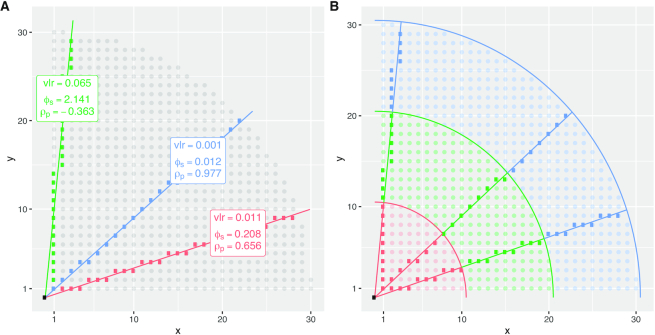
Lattice compositions cannot, in general, exactly represent proportional relationships between pairs of components, and this affects statistical measures of proportionality. (A) This plot shows three different colored lines of exact proportionality between x and y; the colored points show their discrete lattice approximation. The slopes of the lines are 1/3 (red), 9/10 (blue) and 10/1 (green). The corresponding proportionality statistics of the lattice approximations are shown in the boxes using logarithms to base 10. Note that we have used a third component \documentclass[12pt]{minimal}
\usepackage{amsmath}
\usepackage{wasysym}
\usepackage{amsfonts}
\usepackage{amssymb}
\usepackage{amsbsy}
\usepackage{upgreek}
\usepackage{mathrsfs}
\setlength{\oddsidemargin}{-69pt}
\begin{document}
}{}$z$\end{document} = 1 (not shown) to ensure that ϕs and ρp are defined. Also, we have defined the lattice approximation so that 1 is the minimum x and y value to avoid taking logarithms of 0. (B) Keeping the same lines of exact proportionality as in (A), we now use colors to indicate different regions of the natural number lattice from radius 1–10 (red), 10–20 (green) and 20–30 (blue). By sweeping a line of proportionality through positive slopes from 0 to ∞ (i.e. angles 0–90° to the x-axis), we can record the values of vlr, ϕs and ρp in different regions of the lattice approximation.